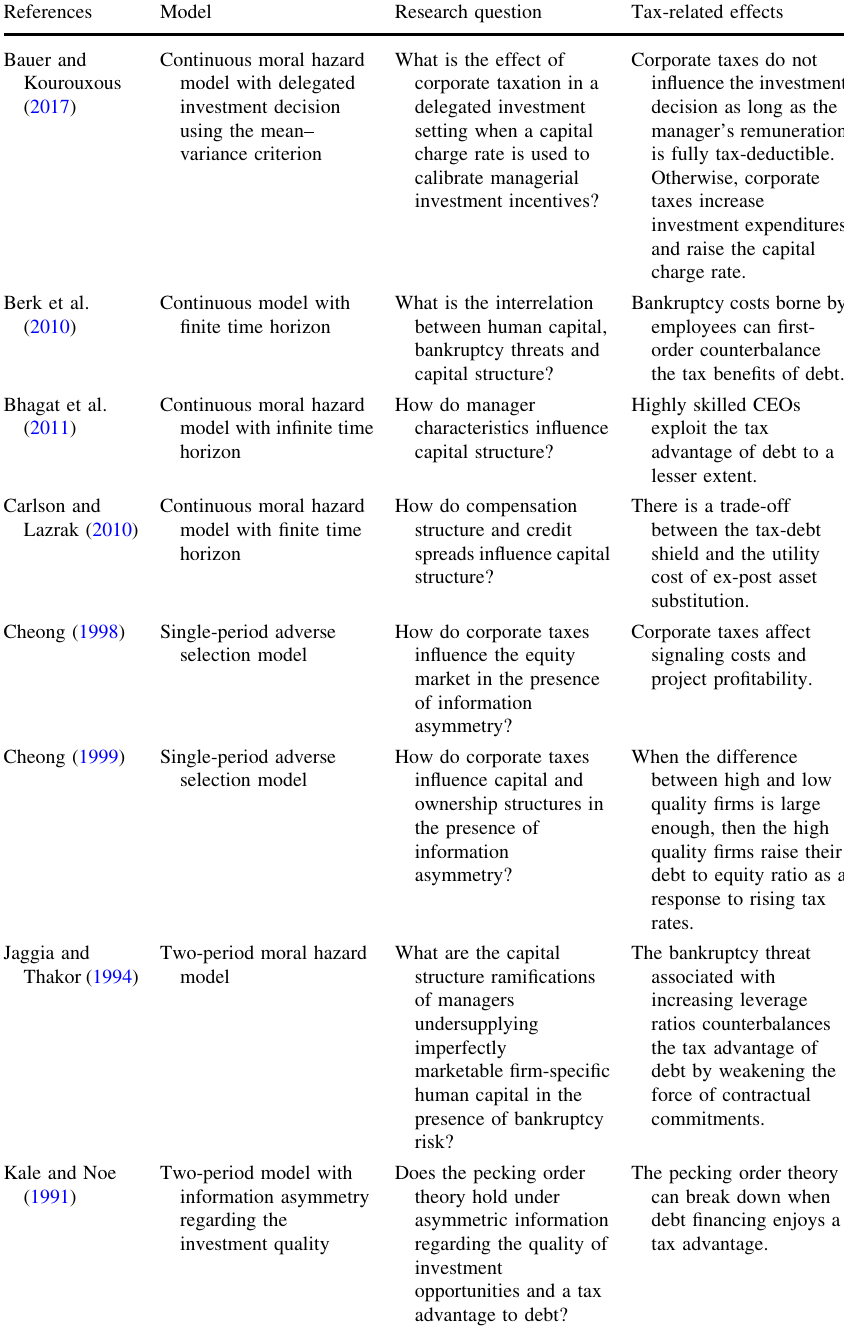
Table 3 Corporate taxes, investment decisions and capital